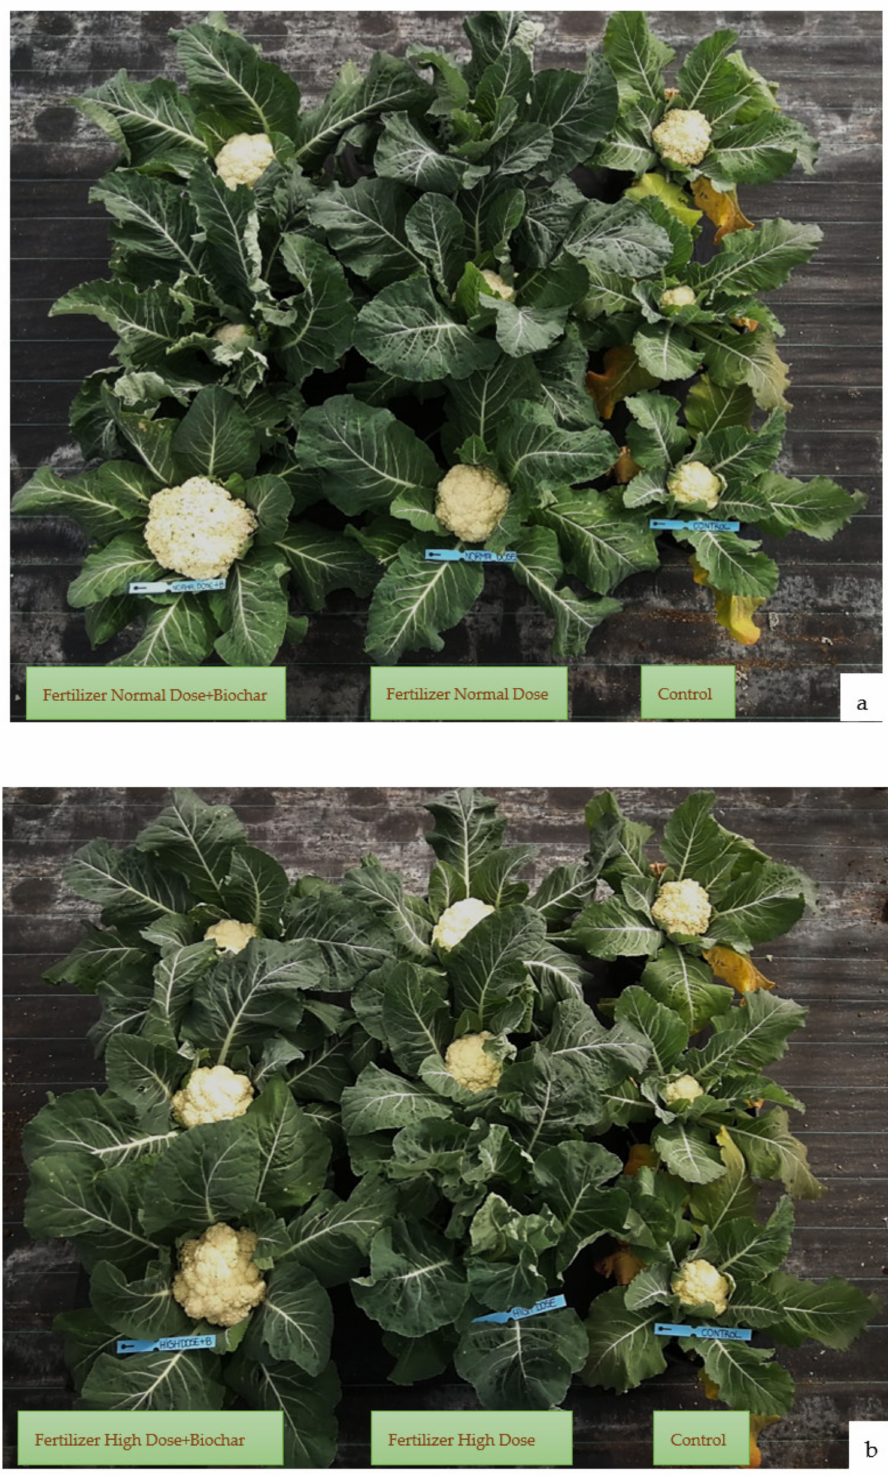
Figure 6. Cauliflower plants treated with 130 kg N ha − 1 ( a ) and 260 kg N ha − 1 ( b ) of fertilizer, with and without biochar, and compared to an untreated